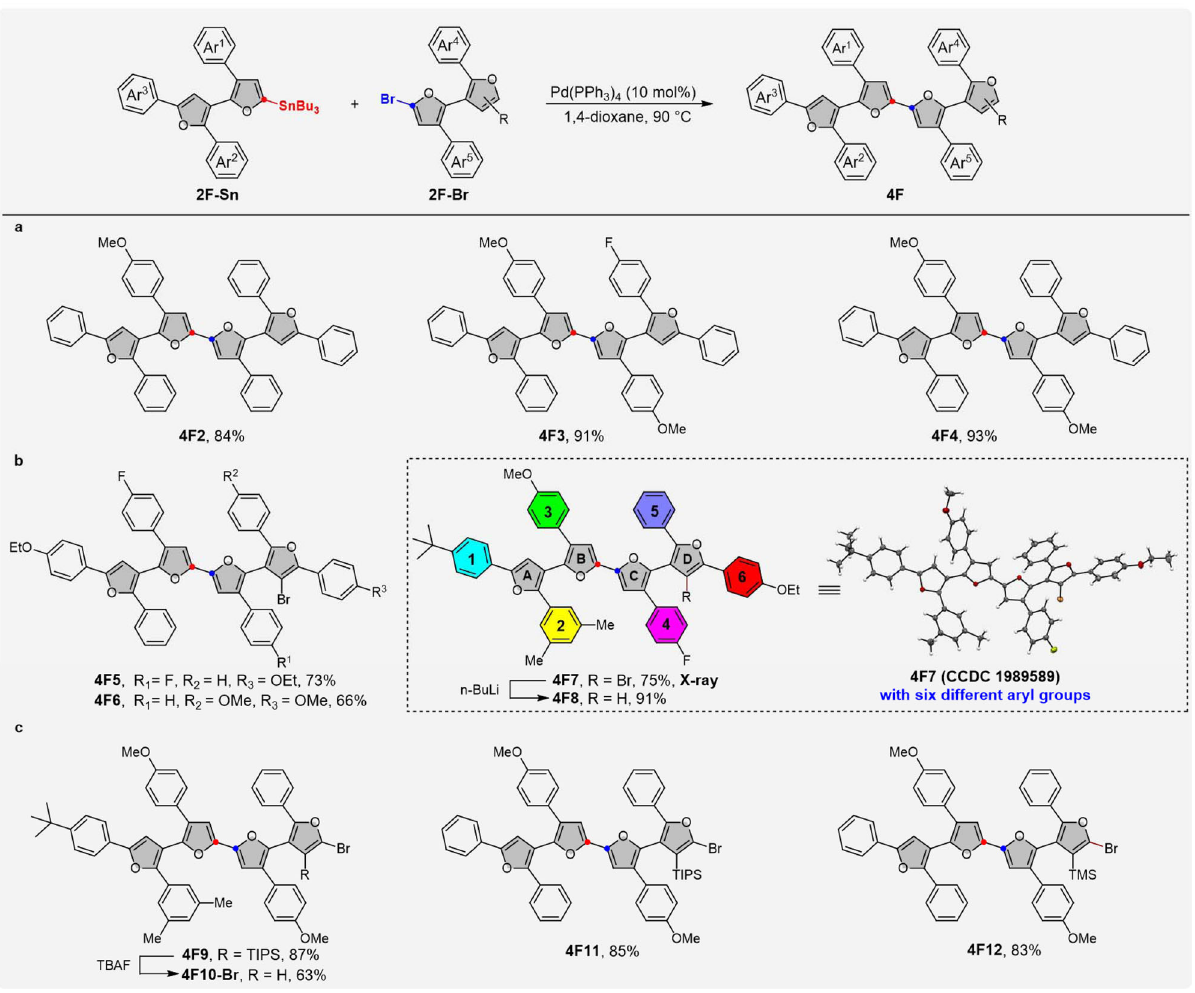
Fig. 4 Substrate scope for the synthesis of tetrafurans. a Scope of tetrafurans. b Scope of 3-bromo-oligofurans. c Scope of 3-silyl-2-bromo-oligofurans. Stille couping conditions: Pd(PPh 3 ) 4 (10 mol%), 1,4-dioxane, 90 °C,